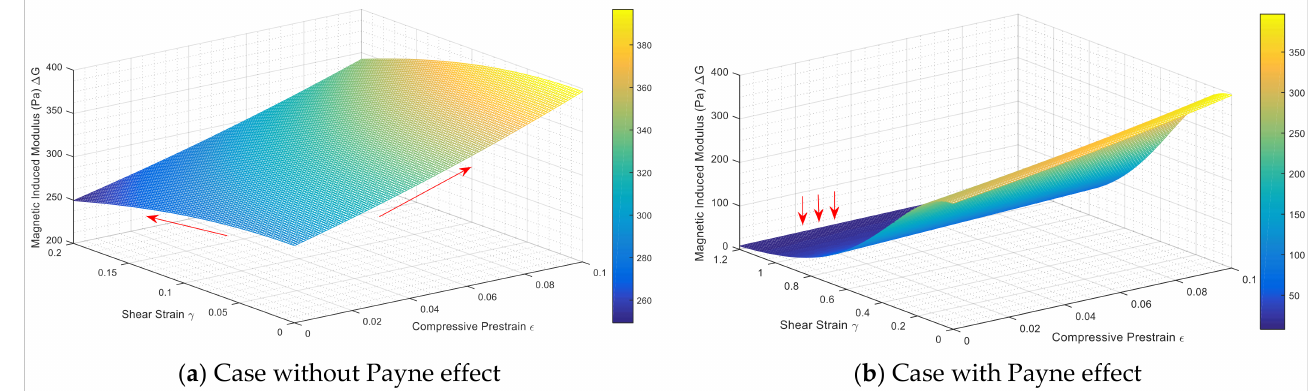
Figure 2. Microscopic